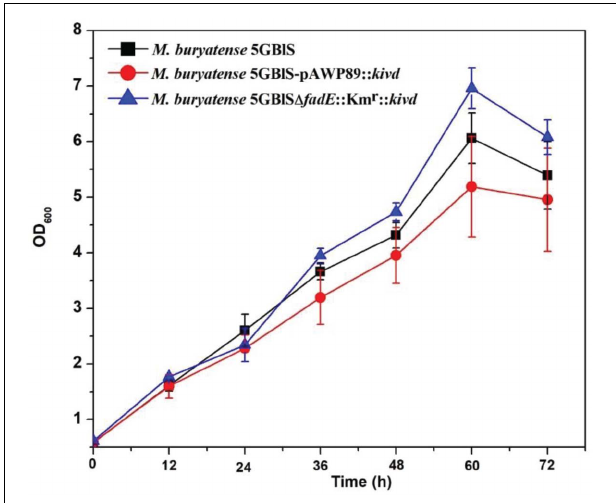
FIGURE 4 | Growth performance of the wild-type ( Methylomicrobium buryatense 5GB1S) and mutant strains for isobutyraldehyde biosynthesis.